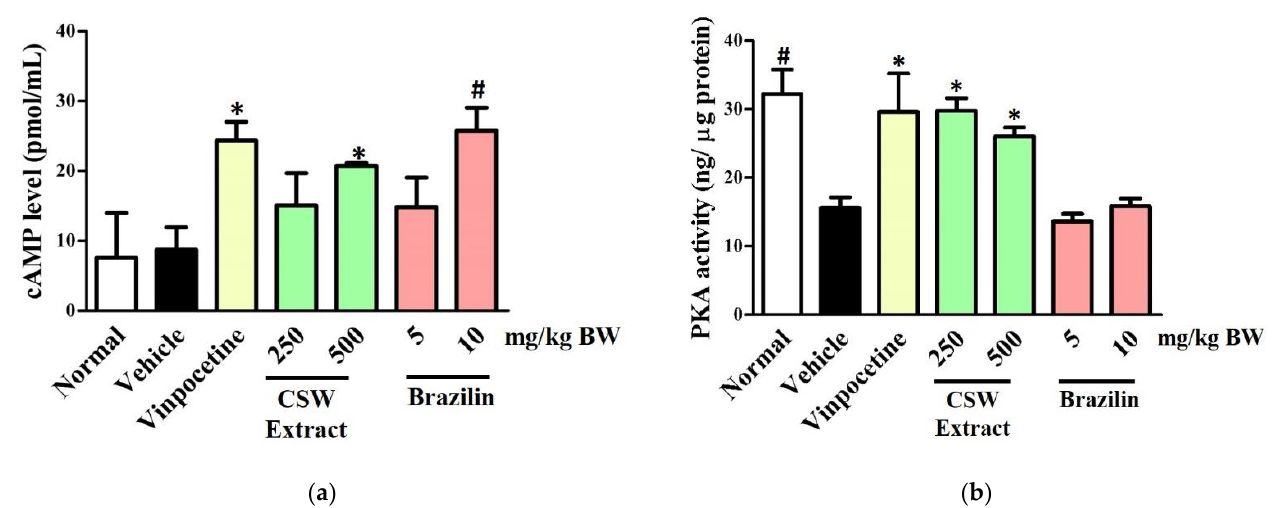
Figure 4. Effect of CSW ethanolic extract and brazilin on ( a ) cAMP levels and ( b ) PKA activity in the hippocampus. Data are presented as mean ± SEM ( n = 3) and were analyzed using a one-way ANOVA followed by the LSD post-hoc test. * p < 0.05 and # p < 0.01 indicate significant differences compared to the vehicle (untreated) group.